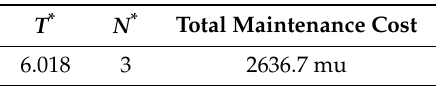
Table 4. Case 1: Maintenance plan for GPM